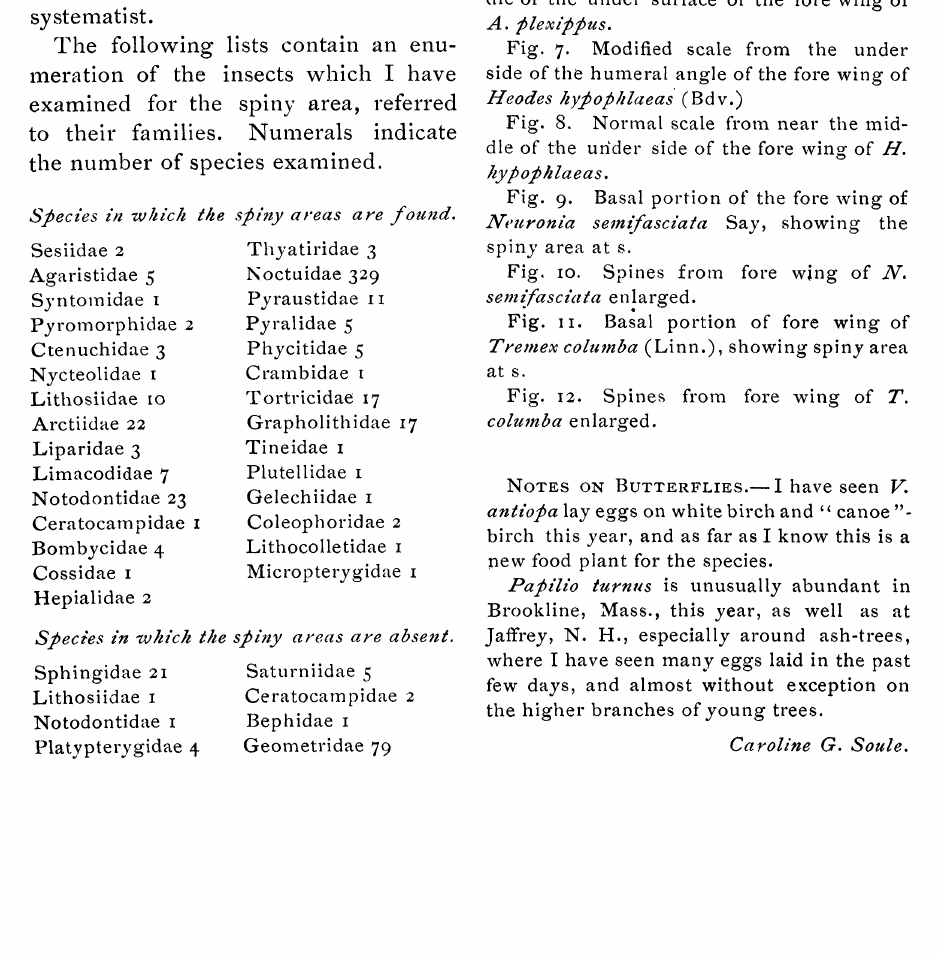
Fig. I. Dorsal view of denuded body of Catocala cocumbe,s Walk., showing the spiny area on the wing at s, and the corres- ponding area on the thorax at S. Fig. 2. Portion enlarged from edge of the spiny area on wing of C. concumbens. Fig. 3. Side view of the spines as seen from the edge of a fold through the spiny area on fore wing of C. concumbens. Fig. 4. Lateral view of denuded body of C. concumbens showing the spiny area at S Fig. 5. Modified scale from the under side of the humeral angle of the fore wing of Anosa lex@pus (Linn.) Fig. 6. Normal scale from near the mid- dle of the under surface of the fore wing of A. #lex@jus. Fig. 7" Modified scale from the under side of the humeral angle of the fore wing of Ileodes kyoklaeas" (Bdv.) Fig. 8. Normal scale from near the mid- dle of the urider side of the fore wing of H. kyioklaeas. Fig. 9. Basal portion of the fore wing of iVeuronia sen/fasciata Say, showing the spiny area at s. Fig, IO. Spines from fore wing of _iV. sem(fasciata en!arged. Fig. II. Basal portion of fore wing of Tremex columba (Linn.), showing spiny area at s. Fig. i2. Spines from fore wing of T. columba